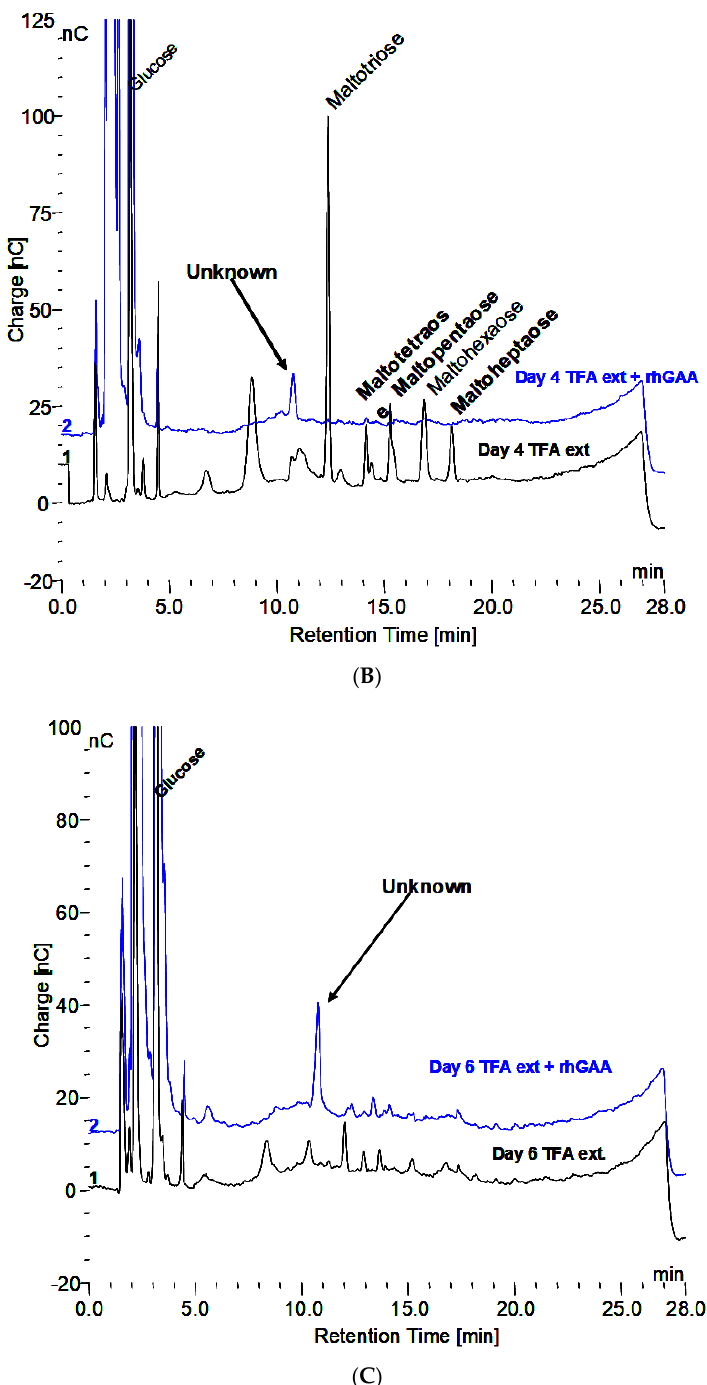
Figure 1. ( A ) Incubation medium of Control 2 with rhGAA after 4 and 6 days, HCl extract of the same and 2N TFA hydrolyzate of same. ( B ) Incubation medium of Control 2 glycogen with rhGAA after 4 days: 2N TFA hydrolyzate and same incubated with rhGAA. ( C ) Incubation medium of Control 2 glycogen with rhGAA after 6 days: 2N TFA hydrolyzate and same incubated with rhGAA. Reaction mixture from rhGAA degradation of Control 2 glycogen was subjected to the scheme shown in Figure 2A. At each of the six steps, the sample was analyzed and the results are shown in Figure